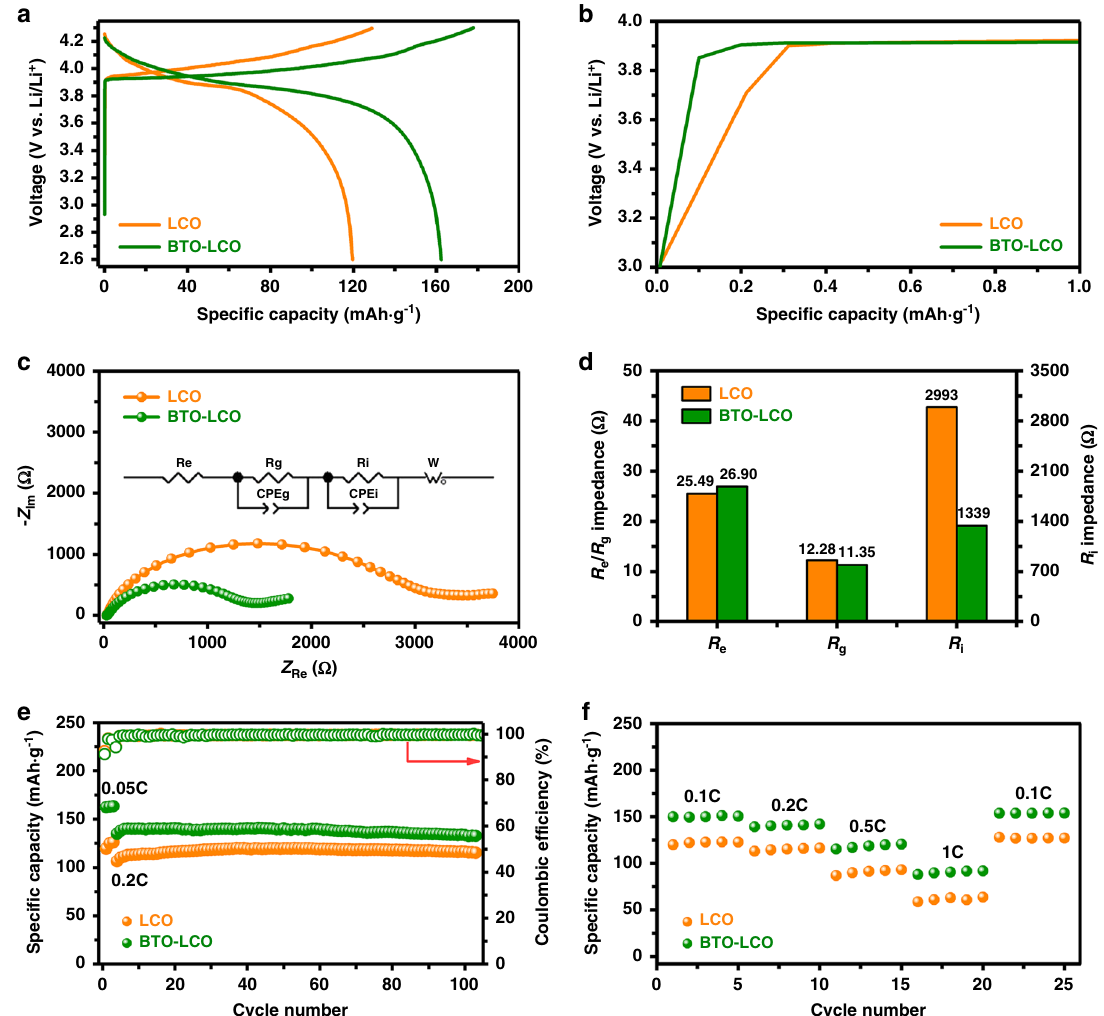
Fig. 3 Electrochemical performances of LCO and BTO – LCO. a First galvanostatic charge – discharge curves of LCO/In – Li and BTO – LCO/In – Li all-solid-state cells at 0.05 C. b Enlarged curves for the initial charge state in a . c , d EIS results of LCO/In – Li and BTO – LCO/In – Li all-solid-state cells after the fi rst cycle. The inset shows the equivalent circuit used for fi tting the experimental EIS data. e Cycling performance of LCO/In – Li and BTO – LCO/In – Li all-solid-state cells at 0.2 C after pre-cycling of three cycles at 0.05 C. f Rate capability of LCO/In – Li and BTO – LCO/In – Li all-solid-state cells. All cells are measured at 30 °C between 2.0 and 3.7 V (vs. In/InLi), corresponding to ~2.6 – 4.3 V (vs. Li/Li + 119.6 mAh g − 1 even at the low current density of 0.05 C in the initial cycle. By contrast, the BTO – LCO displays a relatively high